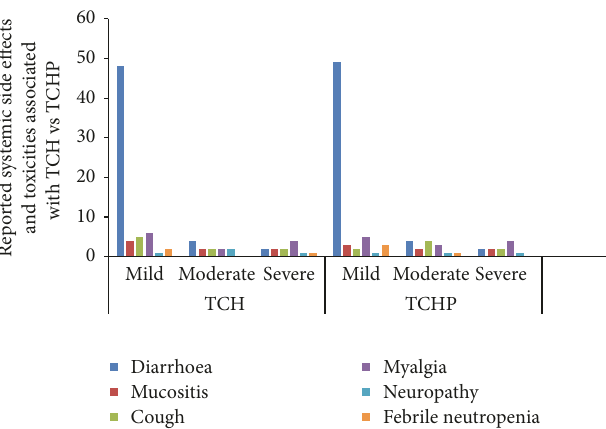
Figure 1: Reported systemic side effects and toxicities associated with TCH (docetaxel, carboplatin, and trastuzumab) versus TCHP (docetaxel, carboplatin, trastuzumab, and pertuzumab). The most common toxicities documented in the patient records by severity are shown. Numbers indicate percentages of patients with documented evidence of specific adverse toxicities. The severity of side effects was established according to Common Terminology Criteria for Adverse Events (CTCAE), Version 4.0, June 2010, National Institutes of Health, National Cancer Institute [6]. Mild side effects were classed as CTCAE grade 1, moderate as CTCAE grades 2-3, and severe as CTCAE grade 4 side effects.